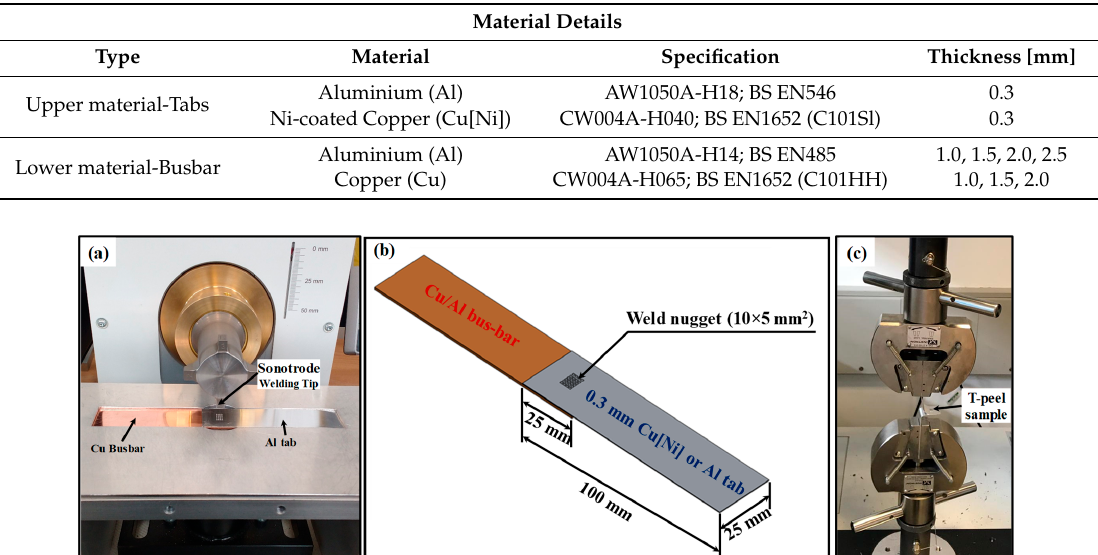
Table 2. Tab and busbar materials used for experimental investigations.